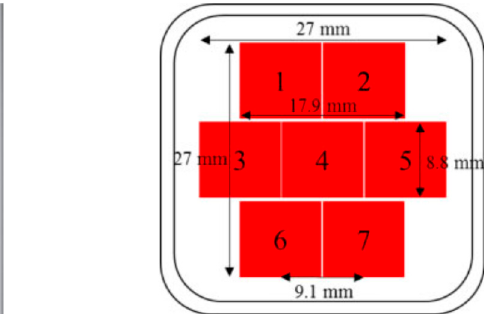
Figure 23. Comparison of transducer output with a heavy matching layer, without a heavy matching layer, and with a conventional approach. Reproduced from [448] with permission from Copyright (2016) The Japan Society of Applied Physics. 5.1.3. Dental Piezoelectric vibrators with kilohertz-frequency vibrating tips have been used for scaling teeth, and limited developments have been realized for the diagnostic imaging of tooth when compared to medical diagnostics [449]. Imaging has been realized involving surrounding organs such as tongue, major salivary gland, lymph nodes, facial, and neck muscles to detect diseases such as carcinomas, periapical lesions, and temporomandibular joint disorders [450]. The reason for limited advancements in the imaging of tooth and the immediate surrounding areas is the anisotropic material properties [451], causing drastic variation in the velocity measurements depending on the position and direction [449]. The geometry of the tooth adds to the prevailing complexities, making the imaging erroneous. The properties of the tooth and its surrounding tissue are listed in Table 6. Table 6. Acoustic properties of typical dental media. 𝒄 𝒍 and 𝒄 𝒕 represent the longitudinal and transverse wave velocity [449,452,453]. Material 𝒄 𝒍 (m/s)